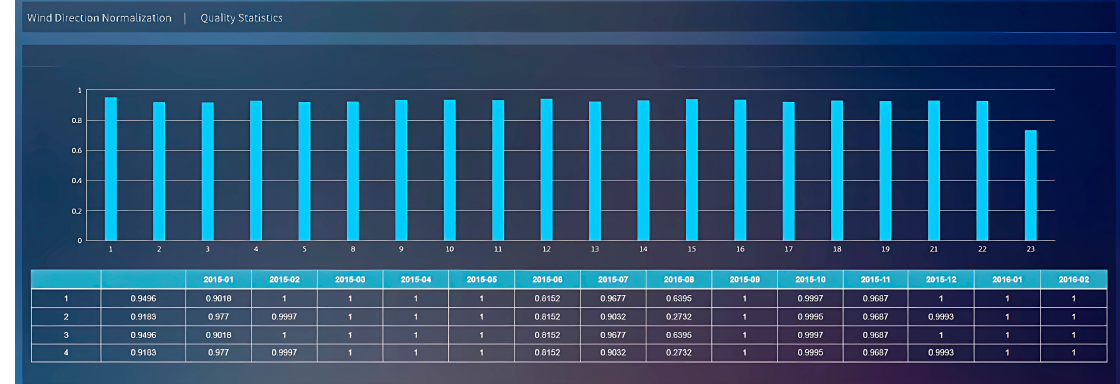
Figure 5. Detection Control and Data Acquisition